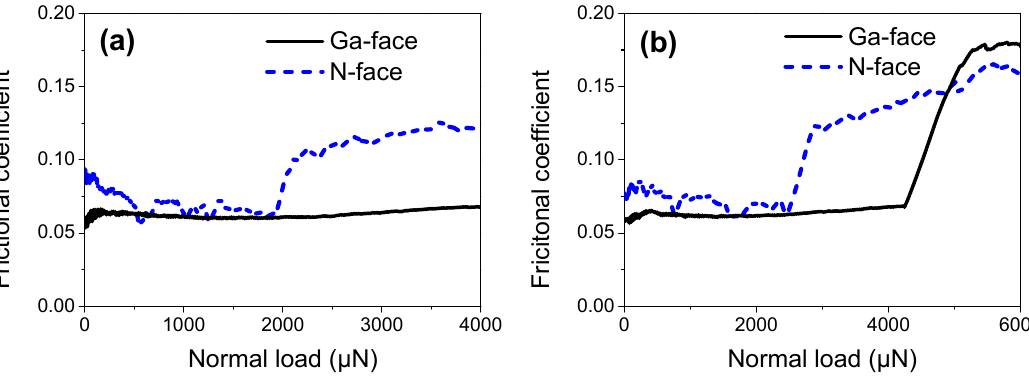
Figure 5. Frictional coefficient varied with the normal load on Ga- and N-faced GaN samples. ( a ) The progressive normal load from 0 to 4000 µ N. ( b ) The progressive normal load from 0 to 6000 µ N.